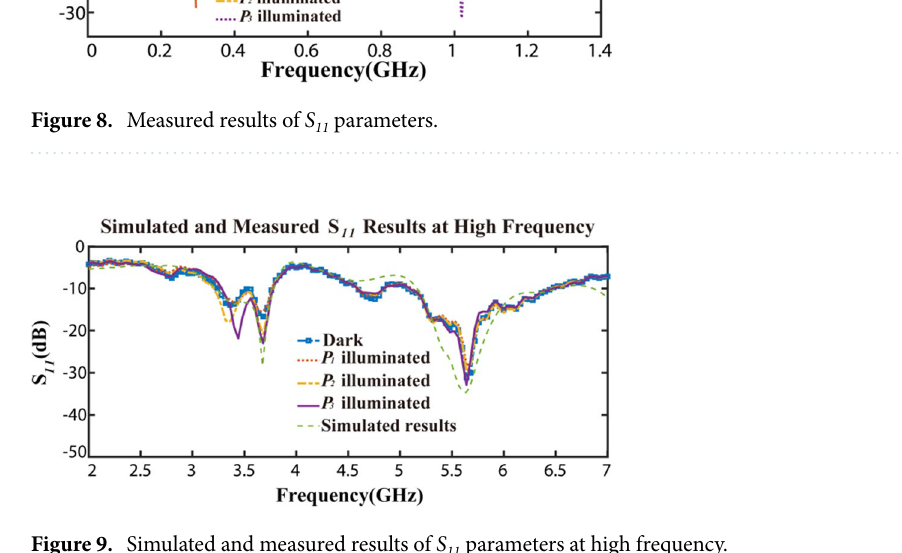
Figure 9. Simulated and measured results of S 11 parameters at high